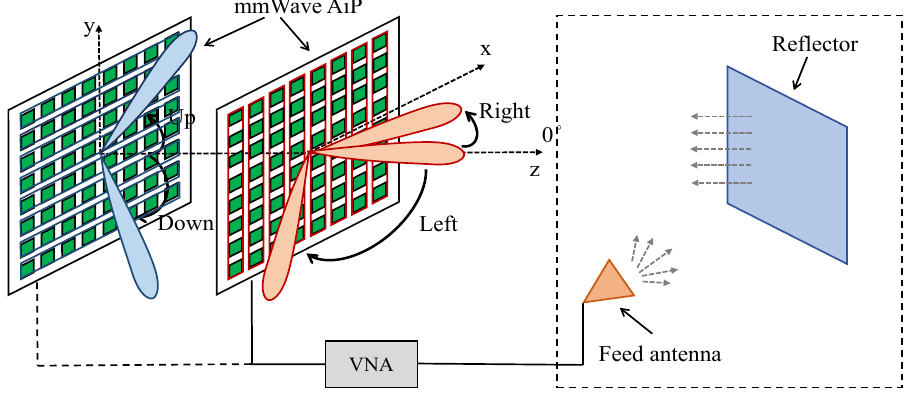
Figure 6. Block diagram of the AiP beamforming pattern measurement